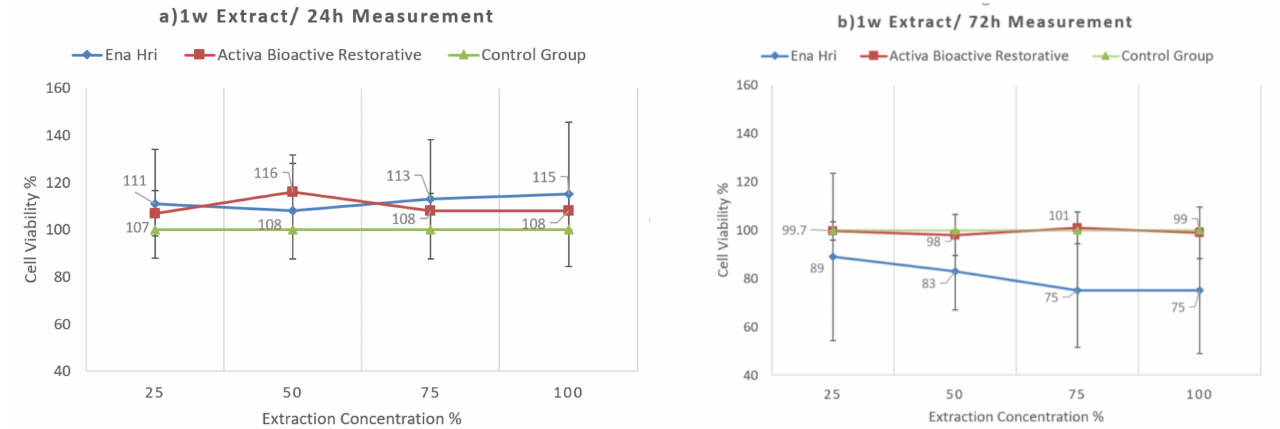
Figure 7. The viability of cells exposed to 1 week extracts of Activa Bioactive Restorative and Ena HRi at ( a ) 24 h and ( b ) 72